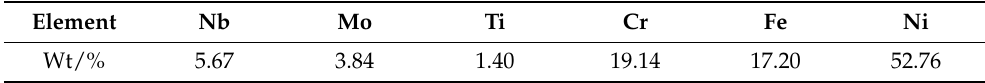
Table 1. Main chemical composition of nickel-based alloy GH4169.